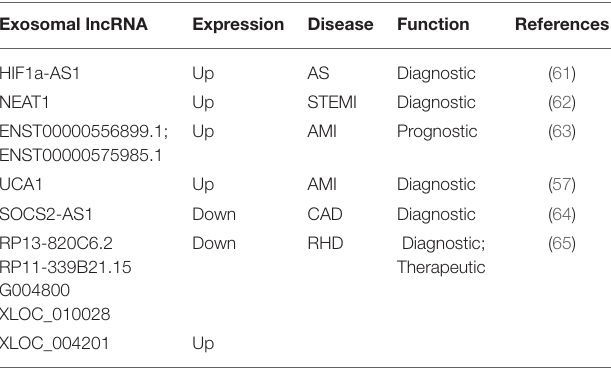
TABLE 2 | The role of serum exosomal lncRNA in cardiovascular disease. Exosomal lncRNA Expression Disease